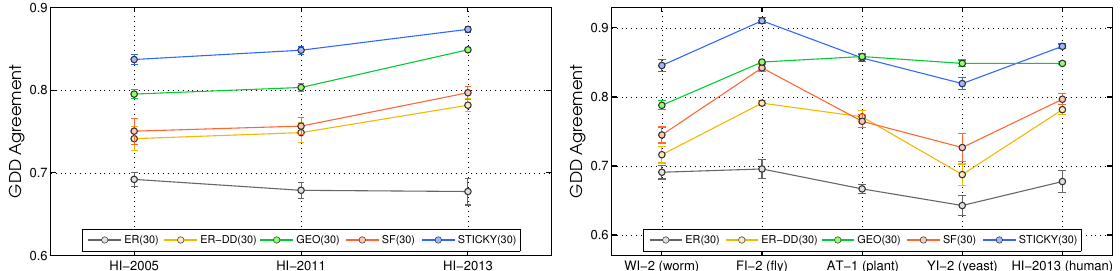
Figure 4: The fit of random network mod- els (ER, ER-DD, GEO, SF, and STICKY) to the three versions of the human PPI net- works.